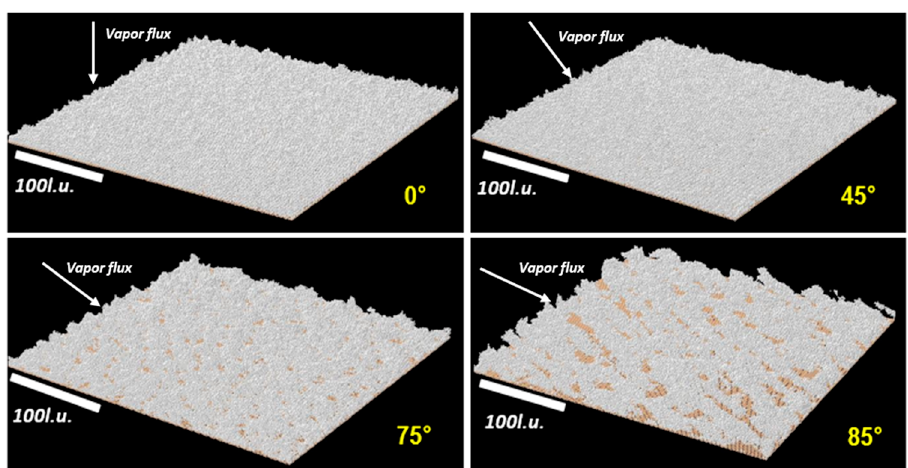
Figure 5. Film growth simulation results at the initial island growth stage (0.5 mL) under different deposition angles.